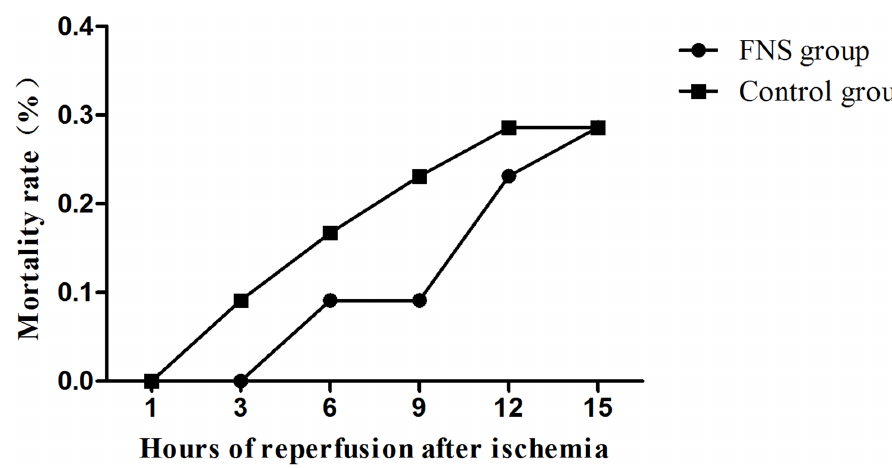
Fig 2. The mortality of two groups. Every group has 10 animals to be survival.